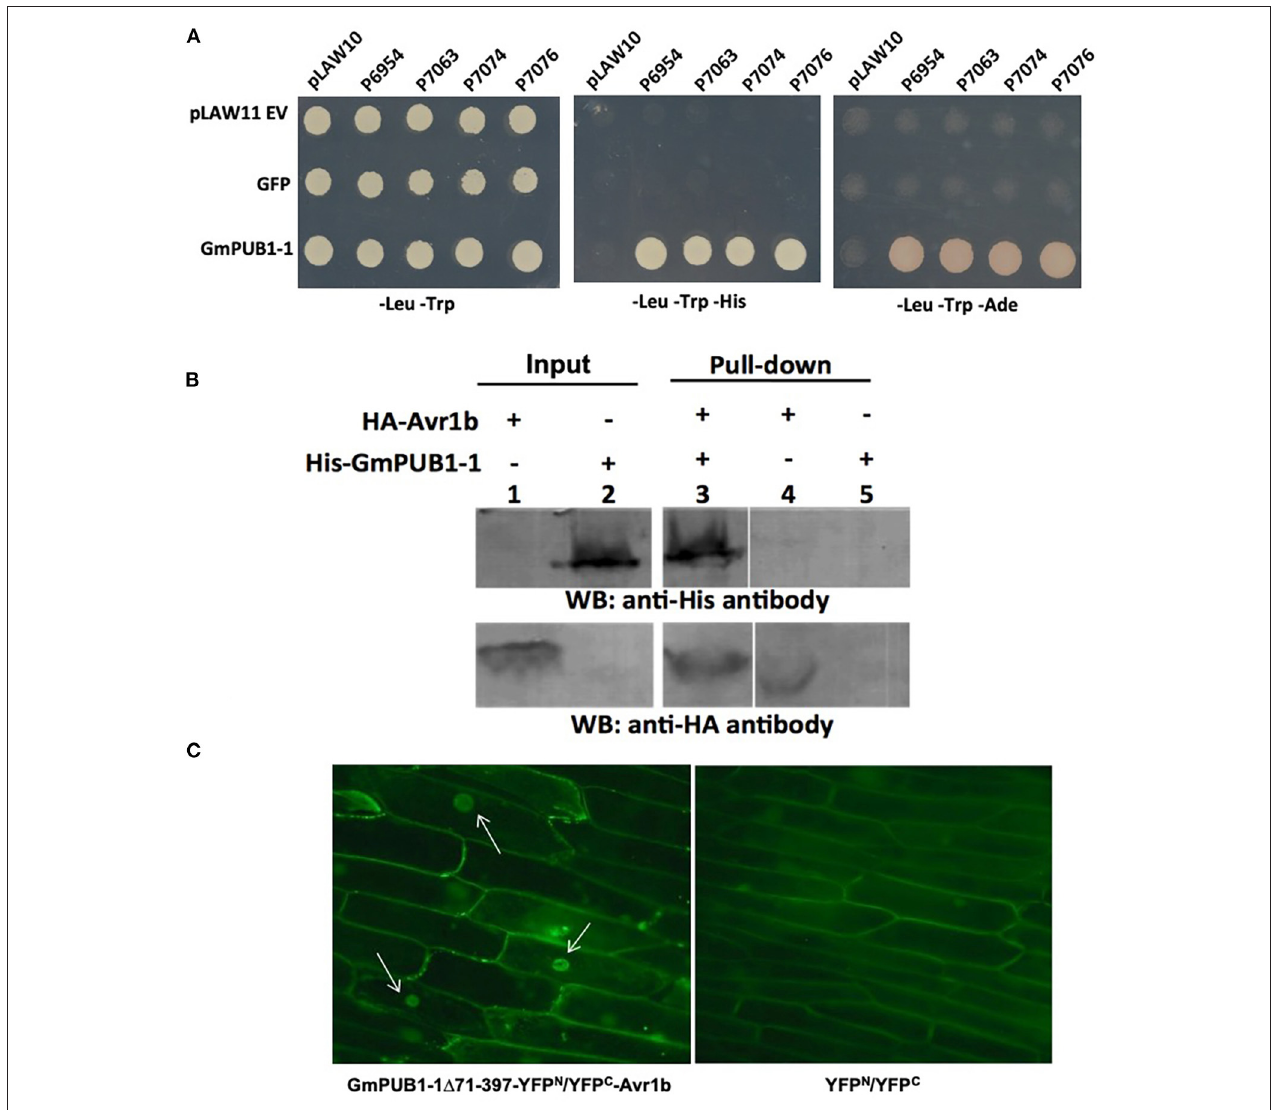
FIGURE 1 | Specific interaction between GmPUB1-1 and Avr1b. (A) Interactions between GmPUB1-1 and four Avr1b alleles, detected by the yeast two-hybrid assay. Avr1b genes from P. sojae strains P6954 (genotype I, race 1), P7063 (genotype IV, race 6), P7074 (genotype III, race 17), or P7076 (genotype II, race 19) were cloned into bait plasmid pLAW10. GmPUB1-1 or GFP genes were cloned into prey vector pLAW11. pLAW10 or pLAW11 were used as empty vector (EV) controls, respectively. Haploids carrying the bait and prey plasmids were mated, and the diploids were tested for growth in the absence of histidine (-His) or adenine (-Ade) indicative of a positive interaction. (B) In vitro interaction of Avr1b with GmPUB1 proteins. Recombinant fusion proteins HA-Avr1b and His GmPUB1-1 were expressed via TNT ® T7-quick-for-PCR DNA system (Promega, Madison, WI). Aliquots of HA-Avr1b (lane 1) or His-GmPUB1-1 (lane 2) proteins used in the pull-down assay were blotted onto membrane and probed with anti-HA and anti-His antibodies, respectively. His-GmPUB1-1 was incubated with HA-Avr1b that was immobilized onto anti-HA agarose beads overnight at 4 ◦ C. The bound proteins were eluted, resolved by SDS-PAGE and blotted onto membrane and then probed with anti-His and anti-HA antibodies, respectively (lane 3). HA-Avr1b (lane 4) or His-GmPUB1-1 (lane 5) alone were used as negative controls. Predicted sizes of the recombinant proteins are: HA-Avr1b, ∼ 18.6 kDa; His-GmPUB1-1, ∼ 48 kDa. (C) BiFC analysis showing in planta interaction between GmPUB1-1 and Avr1b. (Left) Nuclear fluorescence (arrows) observed from complementation of the C-terminus of YFP fused to Avr1b (Avr1b-C-EYFP) with the N-terminus of YFP fused to GmPUB1-1 71 − 397 (GmPUB1-1 71 − 397 -N-EYFP) after bombardment into onion bulb epidermal cells. (Right) No fluorescence was detected in controls with C-EYFP and N-EYFP